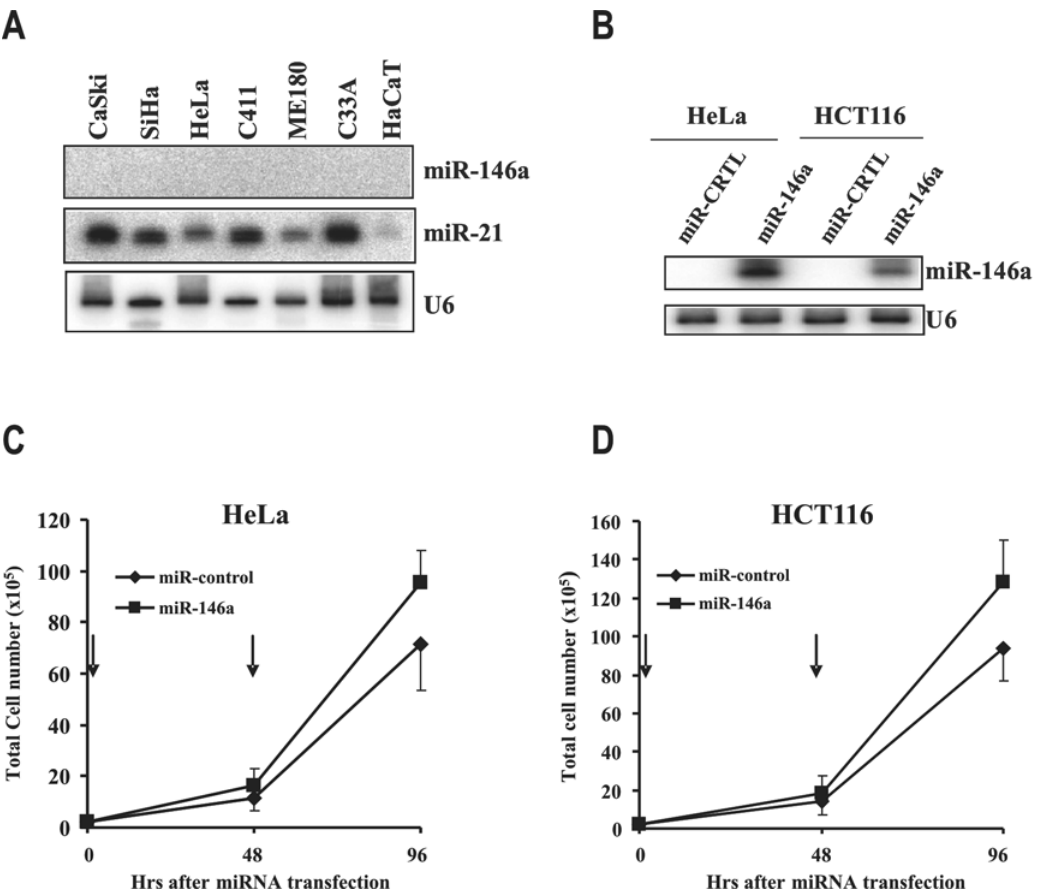
Figure 7. Overexpression of miR-146a promotes cell proliferation. A . No expression of miR-146a in cervical cancer-derived cell lines and in a human skin-derived keratinocyte line, HaCaT cells. Total cell RNA was extracted from individual cell line and examined for miR-146a and miR-21 expression by northern blotting. U6 in each sample served as sample loading control. B . Relative level of miR-146a in HeLa and HCT116 cells at 96 hrs after the first transfection. Total cell RNA extracted from each group was examined by northern blotting. C and D . miR-146a promotes cell proliferation. Arrows indicate the time points when the cells received transfection with miR-146a or miR-control (30 nM). Viable cells in each group were counted at the indicated time points. Data represent the mean 6 SD of two experiments, each performed in triplicate.